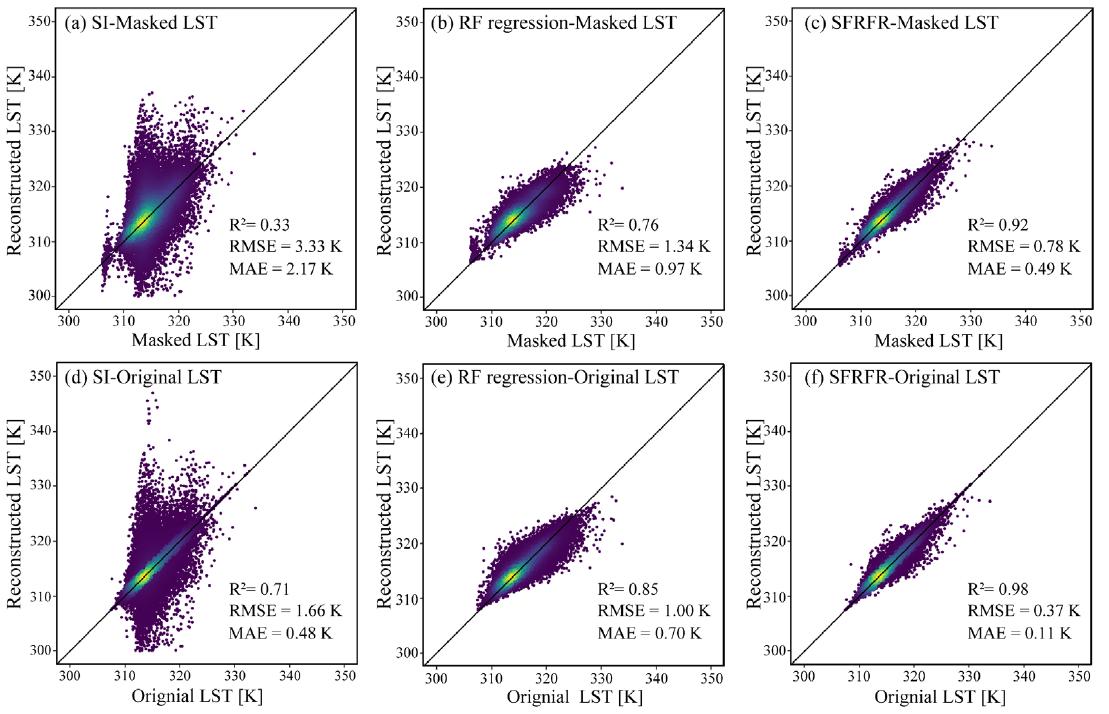
Figure 13. Scatter density plots between the predicted LST and the observed LST under a 250 m spatial resolution: ( a – c ) LST plots constructed by the SI, RF regression, and SFRFR models against masked LST regions; ( d – f ) LST plots reconstructed by the SI, RF regression, and SFRFR models against original LST regions.